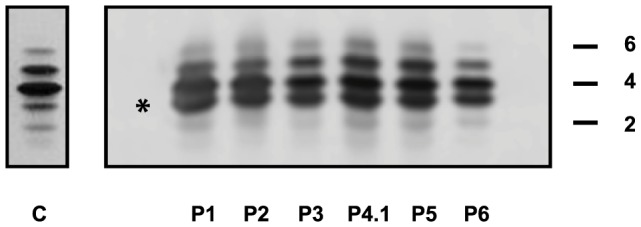
IEF profiles of serum transferrin.Isoelectrofocusing pattern of serum transferrin in MAN1B1-deficient individuals and a control. 2, 4 and 6 indicate disialo-, tetrasialo-, and hexasialotransferrin isoforms, respectively. The asterisk mark represents the trisialotransferrin isoform.